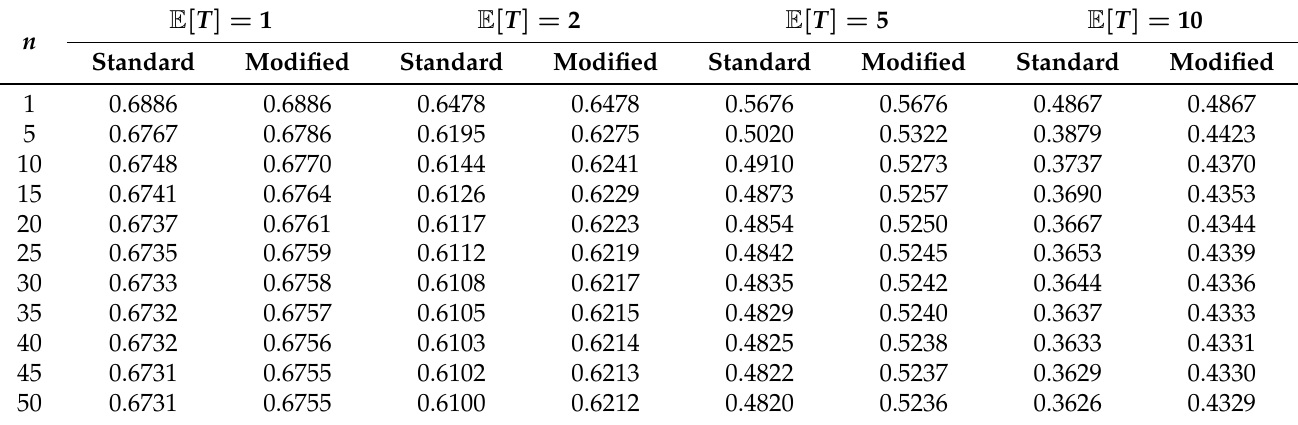
Table 1. Standard and modified Parisian ruin probabilities under exponential claims when u = 0.